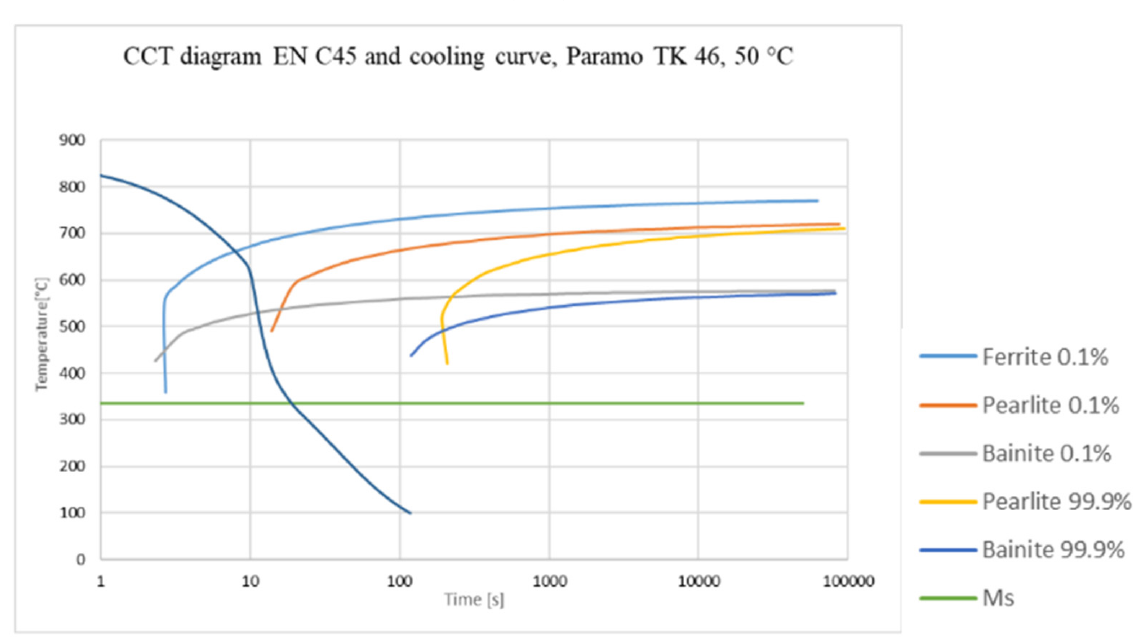
Figure 8. Cooling curve for Paramo TK 46 oil (measured at 50 °C) plotted in a CCT diagram of C45 steel.